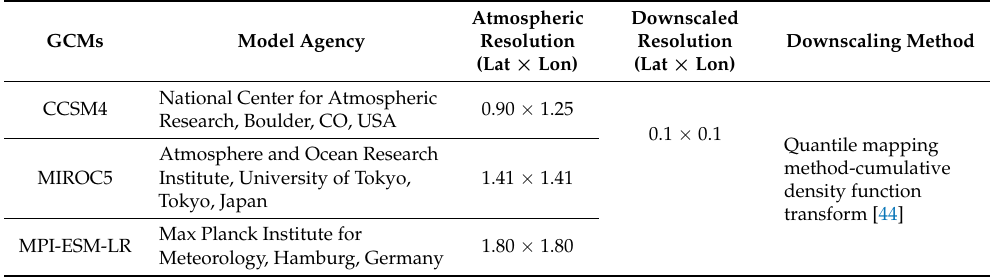
Table 3. The Coupled Model Intercomparison Project-5 global climate models used in the study.